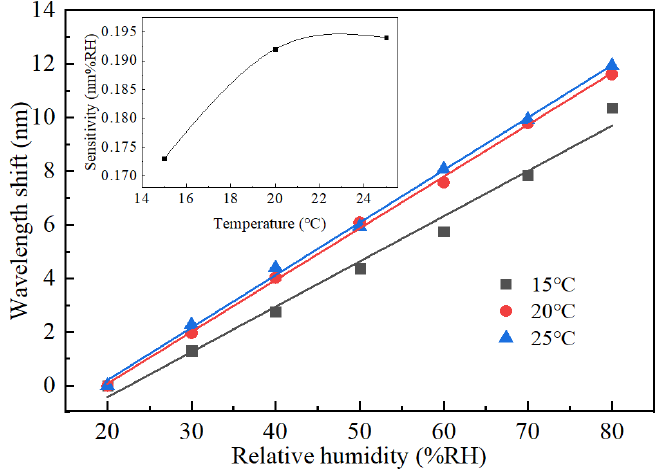
Figure 7. Wavelength shift against RH at different temperatures. Insert is humidity sensitivity of the FPI probe against temperature.